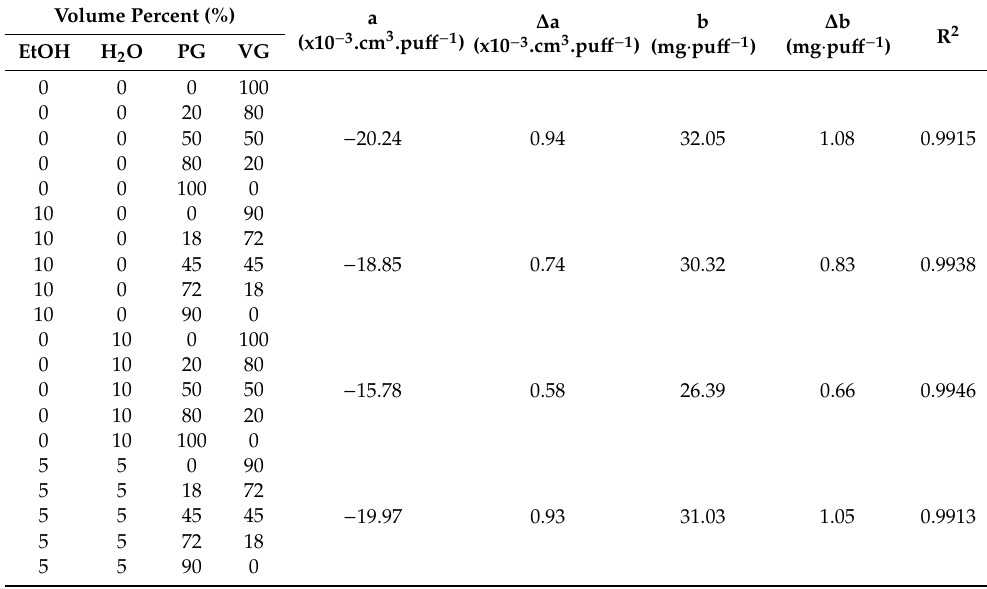
Table 6. MVE — Values of the coefficients, a and b, and their standard deviations, Δa and Δb , in Equation (2) of the {PG-VG}, {PG-VG-EtOH}, {PG-VG-H 2 O}, and {PG-VG-EtOH-H 2 O} ranges (R 2 = coefficient of determination).